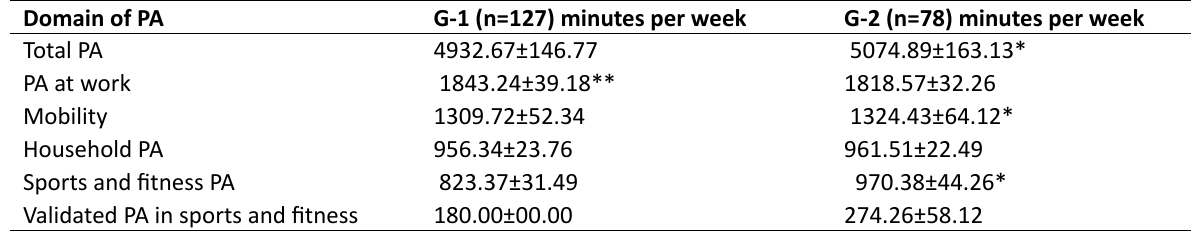
Table 1. Differences in domains of PA of male students (G-1 and G-2).